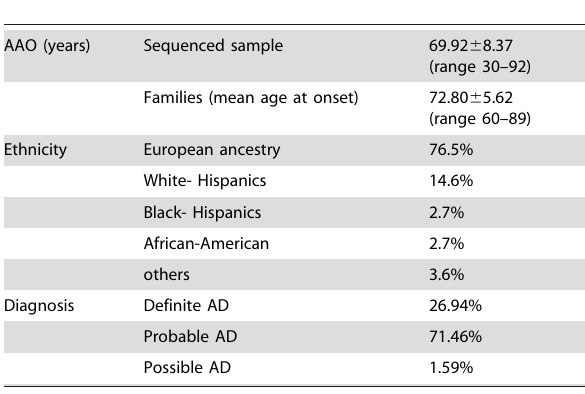
Table 2. Demographic data for the